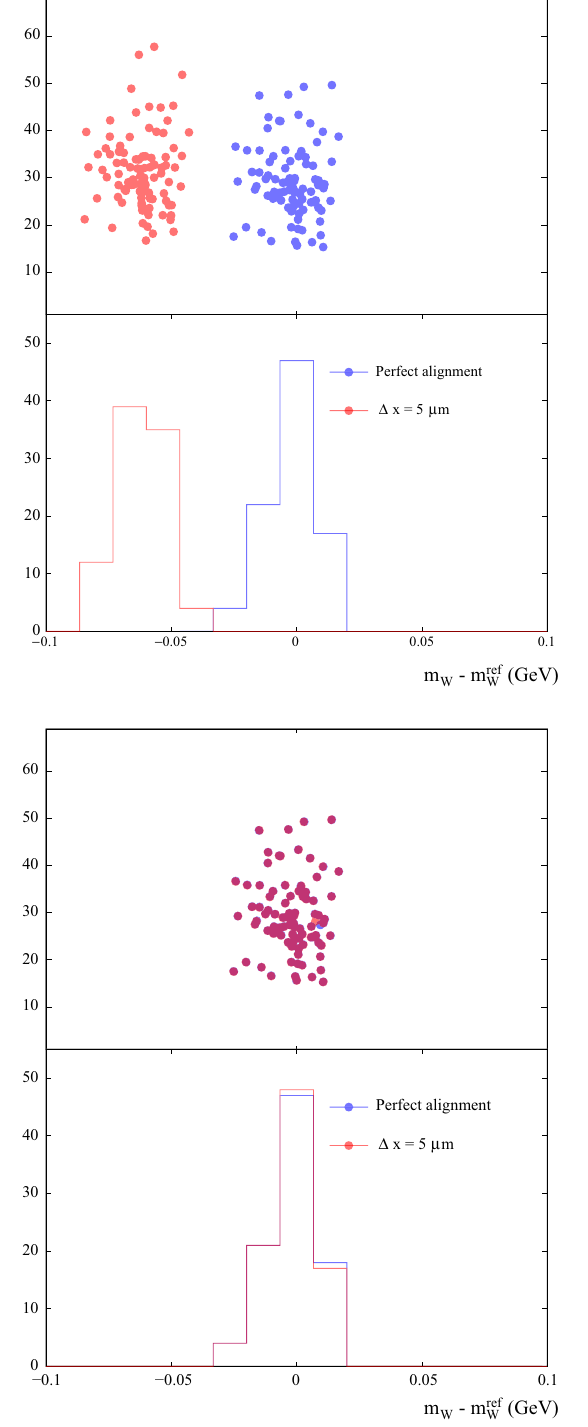
coherent 5 μ m mis-alignment along x . The first (last) row of plots show val- lept the distributions before (after) applying the pseudomass corrections. The upper panel of each plot shows the best-fit χ 2 corresponding to the extraction of m W and sin 2 θ eff for the 90 lept